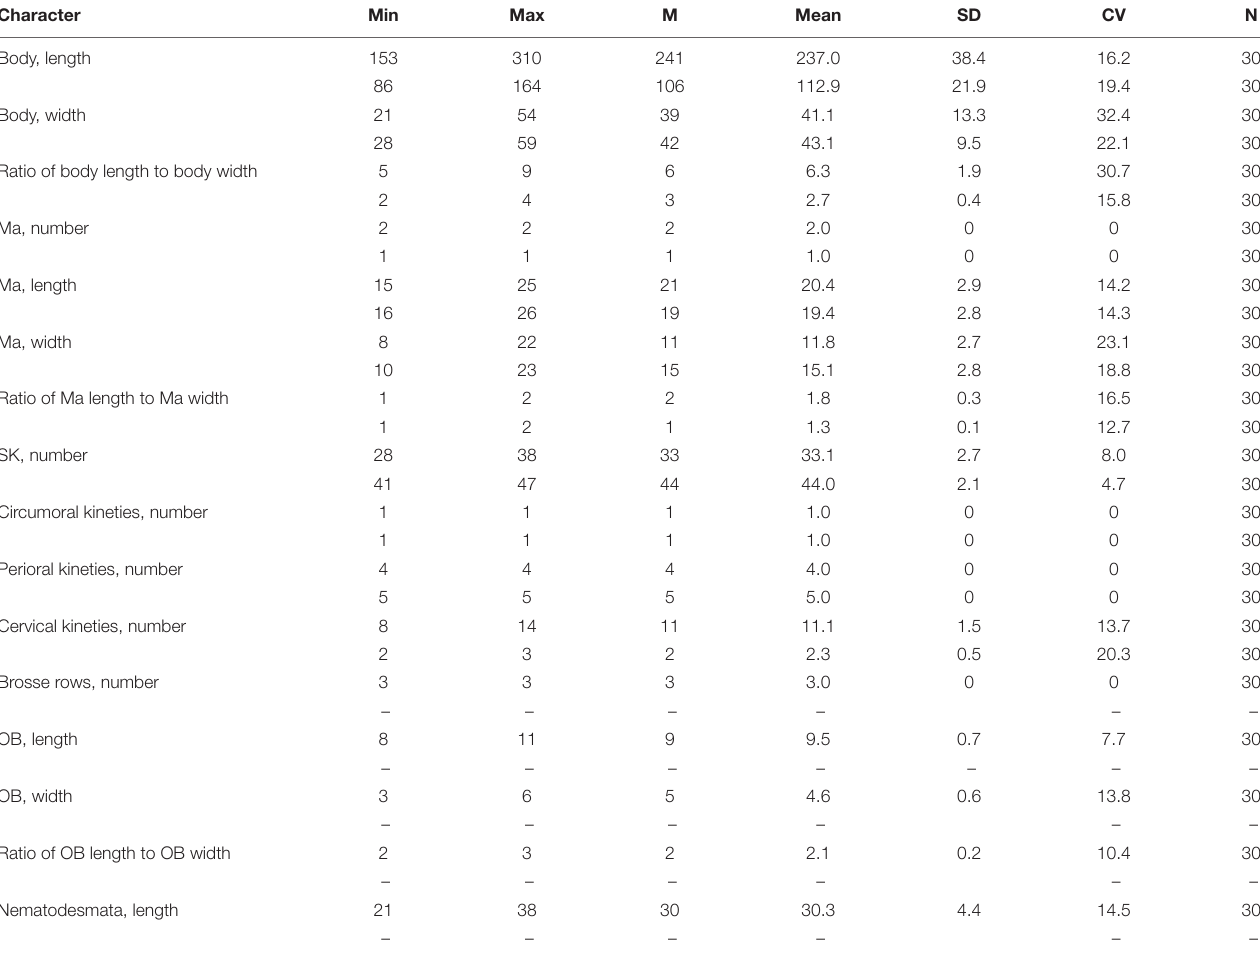
TABLE 1 | Morphometric data on Lagynus binucleatus sp. n. and Foissnerophrys alveolata gen. n., sp. n. after protargol staining. Measurements in µ